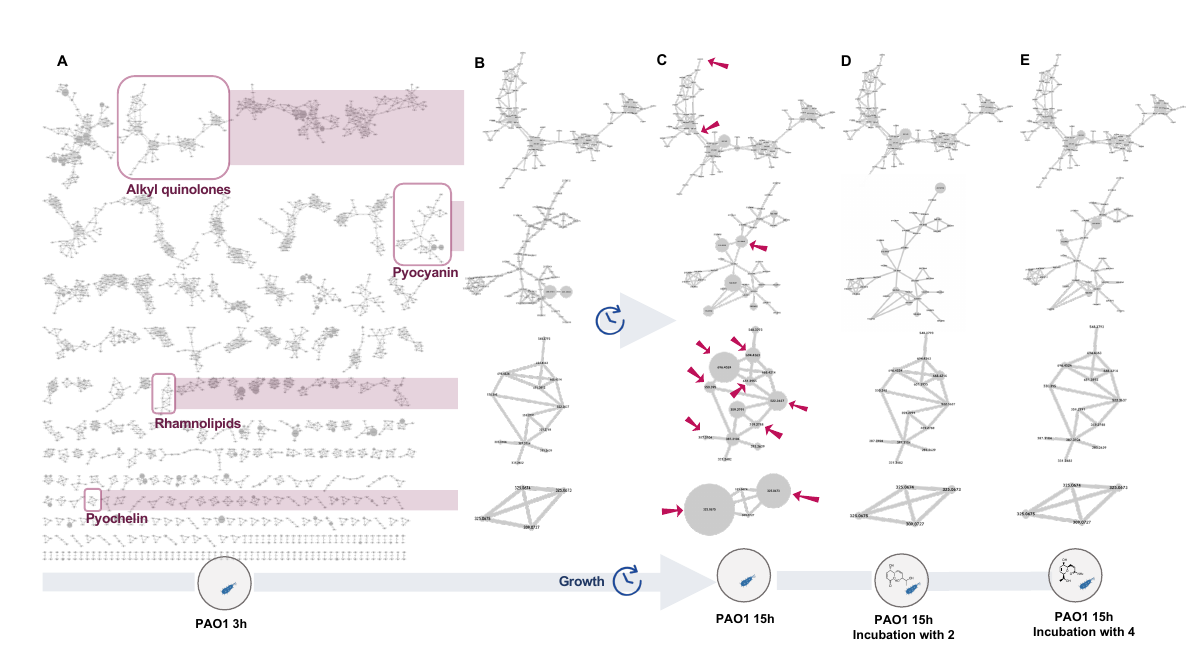
Figure 7. ( A ) Full molecular network of PAO1 alone after 3 h of incubation, with QS-related metabolites clusters highlighted with red squares. ( B – E ) Variation of the intensity of all features associated with virulence factors at 3 and 15 h, with or without incubation with the active compounds. ( B ) Clusters from PAO1 alone after 3 h. ( C ) Clusters from PAO1 alone after 15 h. ( D ) Clusters from PAO1 incubated with compound 2 after 15 h. ( E ) Clusters from PAO1 incubated with compound 4 after 15 h. Compounds were tested in triplicate at a final concentration of 128 µ g/mL. The size of the nodes is proportional to the intensity of each feature in the samples. Metabolites significantly impacted by incubation with 2 or 4 are highlighted by red